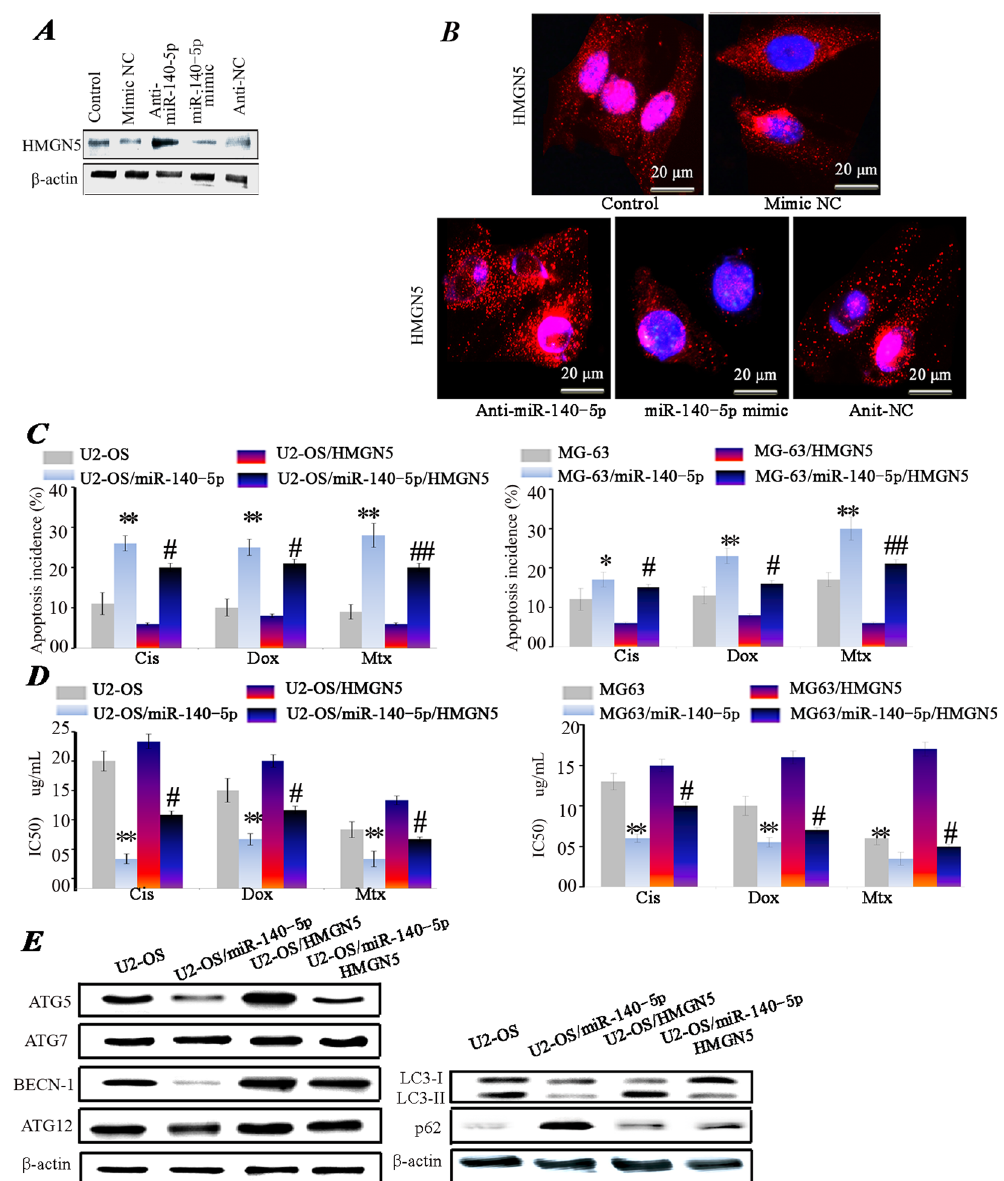
Figure 3. Overexpression of HMGN5 increased chemoresistance and activated autophagy. HMGN5 expression level was evaluated using Western blot ( A ) and Confocal laser scanning microscopy (CLSM) ( B ). Blue fluorescence indicates nuclei stained with DAPI, and red fluorescence indicates the HMGN5 protein. * P < 0.05, ** P < 0.01 vs control. The apoptosis incidence ( C ) and IC50 values ( D ) in U2-OS and MG-63 cells transfected with miR-140-5p in combination with or without Lenti-HMGN5 vector. ( E ) Expression levels of ATG5, ATG7, ATG12, BECN-1, p62 and LC3-II/I proteins in cells transfected with miR-140-5p in combination with or without Lenti-HMGN5 vector. ( * P < 0.05, ** P < 0.01 U2-OS vs U2-OS/miR-140-5p; # P < 0.05, ## P < 0.01 U2-OS/miR-140-5p vs U2-OS/miR-140-5p/HMGN5). The results of p62, LC3-II/I and β -actin were gotten from the second